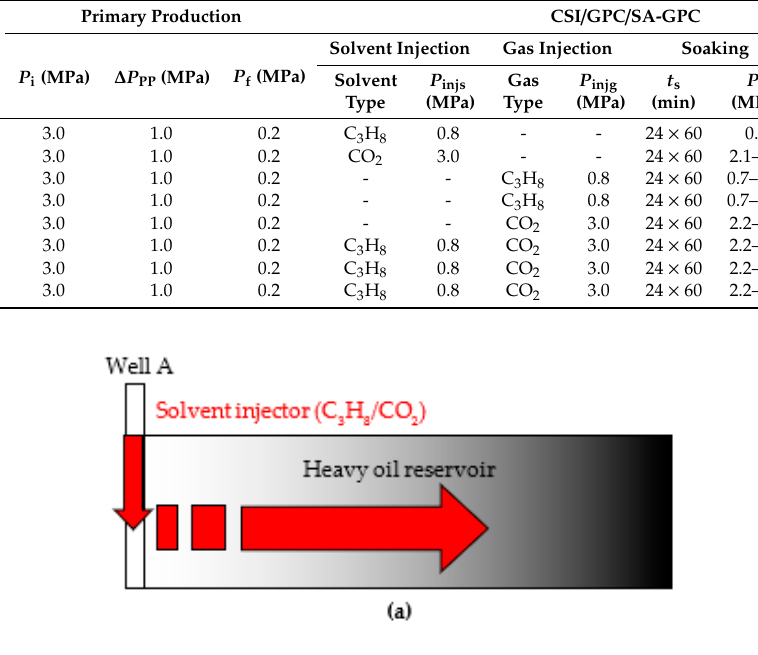
Table 2. Technical details of Tests #1–8 (including the primary production) at T res = 21.0 ◦ C.